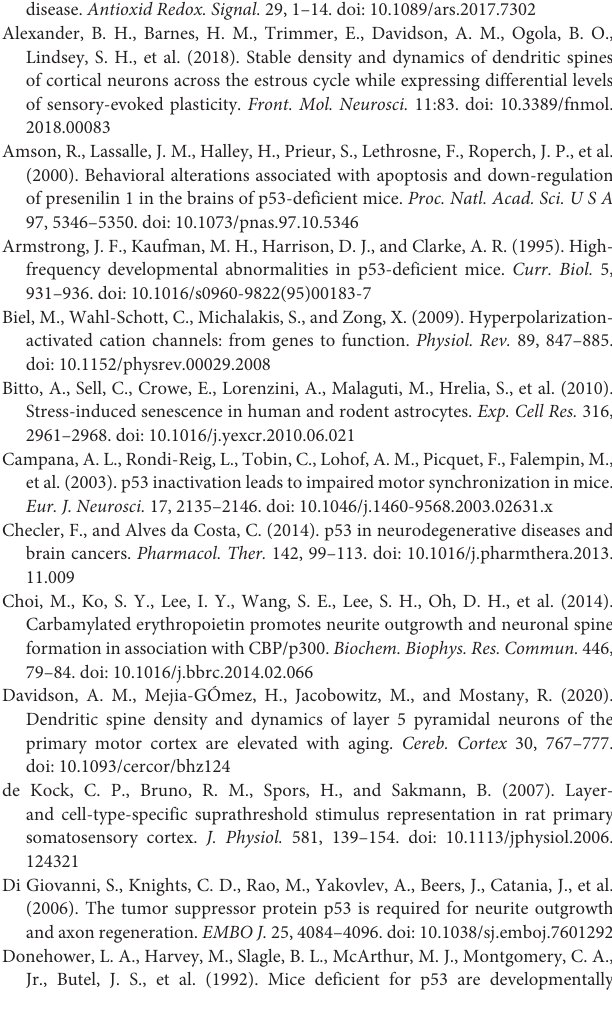
Supplementary Figure 2 | Spontaneous glutamatergic synaptic transmission in L5 pyramidal neurons of WT and KO mice. (A) Quantification of mEPSC amplitude from RS (WT, n = 8; KO, n = 8) and IB (WT, n = 8; KO, n = 14) cells from WT ( N = 7 mice) and KO mice ( N = 8 mice; WT-RS vs. WT-IB, t (14) = 2.454, p = 0.0278; KO-RS vs. KO-IB, t (20) = 1.444, p = 0.1642; unpaired t -test). (B) Quantification of mEPSC frequency (WT-RS vs. WT-IB, t (14) = 2.313, p = 0.0364; KO-RS vs. KO-IB, t (20) = 2.973, p = 0.0075; unpaired t -test). * p < 0.05; ** p < 0.01. Supplementary Figure 3 | Dendritic morphology of neurobiotin-labeled L5 pyramidal neurons. (A) Quantification of normalized cortical depth from pia (WT-RS vs. WT-IB, t (36) = 2.809, p = 0.008; KO-RS vs. KO-IB, t (39) = 1.659, p = 0.1051; unpaired t -test). (B) Quantification of soma size (WT-RS vs. WT-IB, t (36) = 3.368, p = 0.0018; KO-RS vs. KO-IB, t (39) = 2.315, p = 0.0260; unpaired t -test). (C) Quantification of tuft width (WT-RS vs. WT-IB, t (36) = 8.386, p < 0.0001; KO-RS vs. KO-IB, t (39) = 7.093, p < 0.0001; unpaired t -test). (D) Quantification of tuft height (WT-RS vs. WT-IB, t (36) = 7.560, p < 0.0001; KO-RS vs. KO-IB, t (39) = 6.932, p < 0.0001; unpaired t -test). (E) Quantification of length of primary apical dendrites (WT-RS vs. WT-IB, t (36) = 0.4417, p = 0.6614; KO-RS